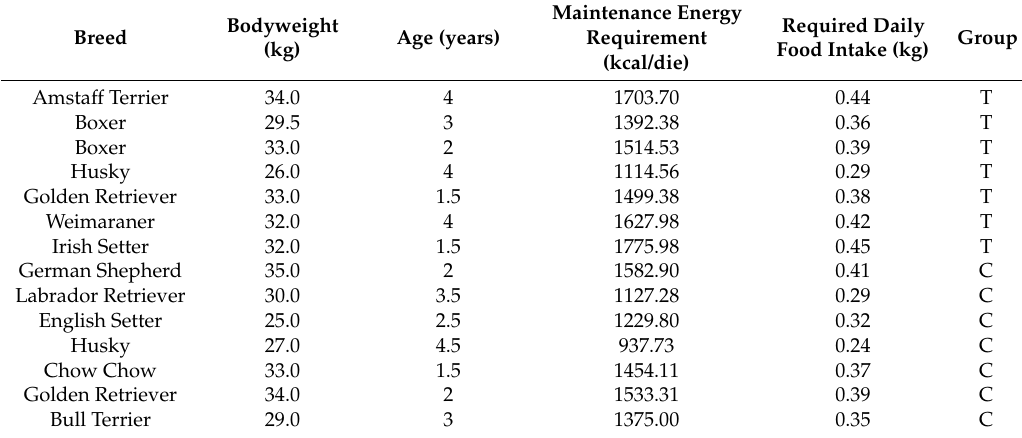
Table 1. Animals enrolled in the treatment (T) and control (C) group and their metabolic